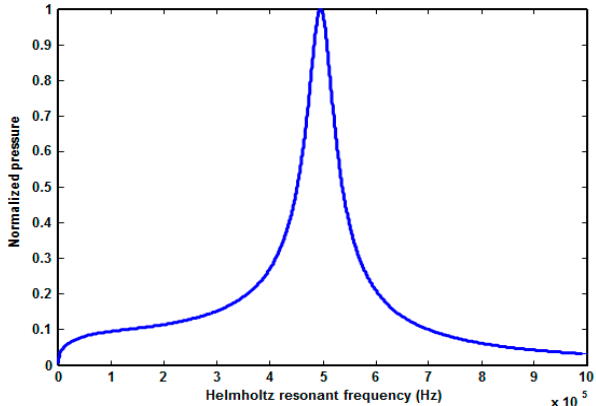
Figure 8. Helmholtz resonant frequency using the LEM.